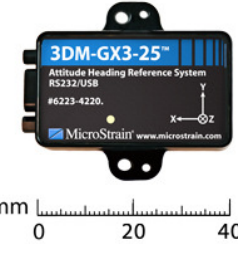
Figure 9. 3DM-GX3-25 inertial measurement unit